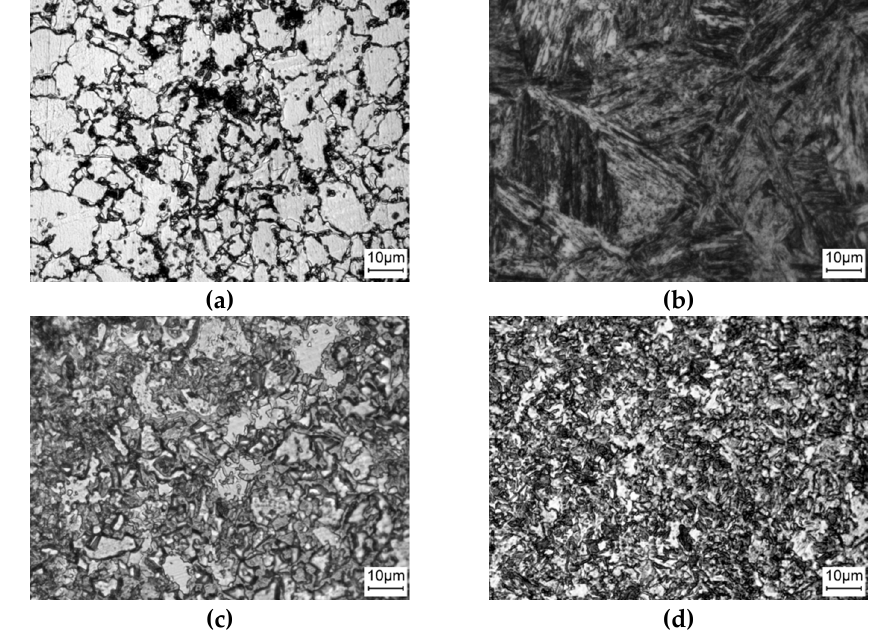
Figure 6. Optical metallographic (OM) photographs of different phase zones: ( a ) soft zone, 210 HV; ( b ) hard zone, 490 HV; ( c ) transition zone, 280 HV; ( d ) transition zone, 375 HV